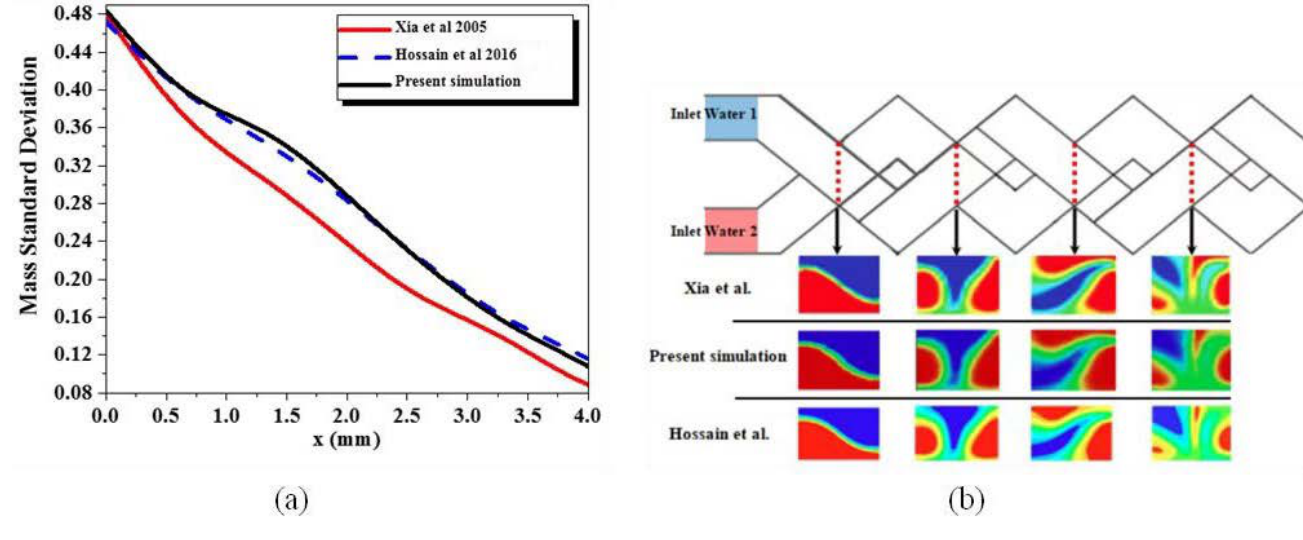
Figure 4. Quantitative validation for mixing efficiency index ( a ), and quantitative validation of local mass fraction contours for various planes ( b ) With the results of Xia et al., reproduced with permission from [15] and Hossain et al. reproduced with permission from [16].